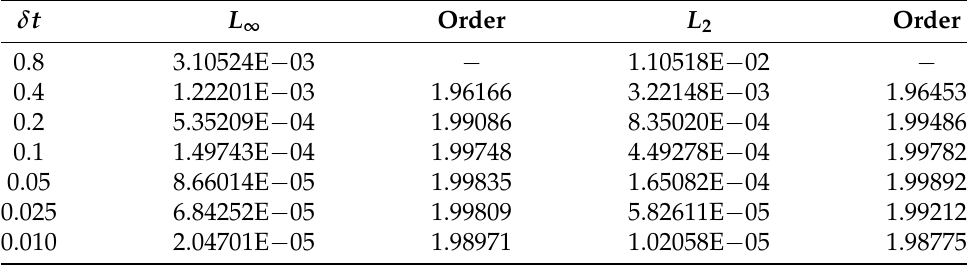
Table 2. Estimated error for the Sinc solution of Equation (1) : t = 16, θ = 1 We used xEy to denote x × 10 y .